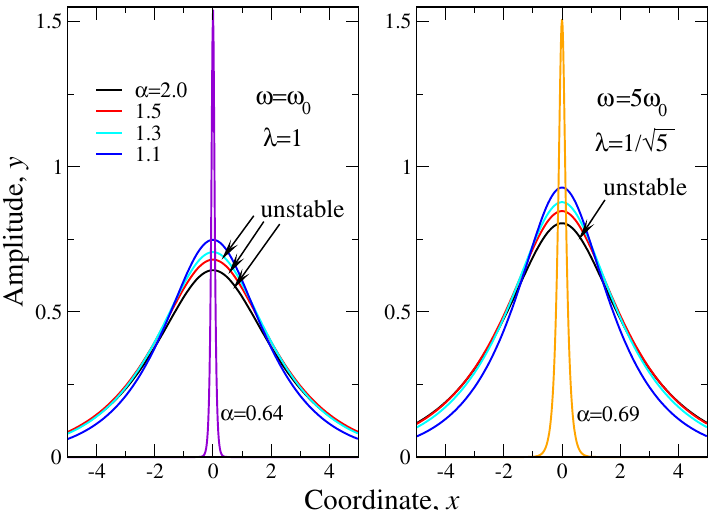
5 ω 0 1 , left panel) and ω ω 0 ( (cid:31) = = = (cid:31) ) cr ( 0.6266 , while for ω 5 ω 0 ( (cid:31) 0.6491 . 1 ) α 1 / √ 5 ) α ω 0 ( (cid:31) cr ≈ cr ≈ = = = =